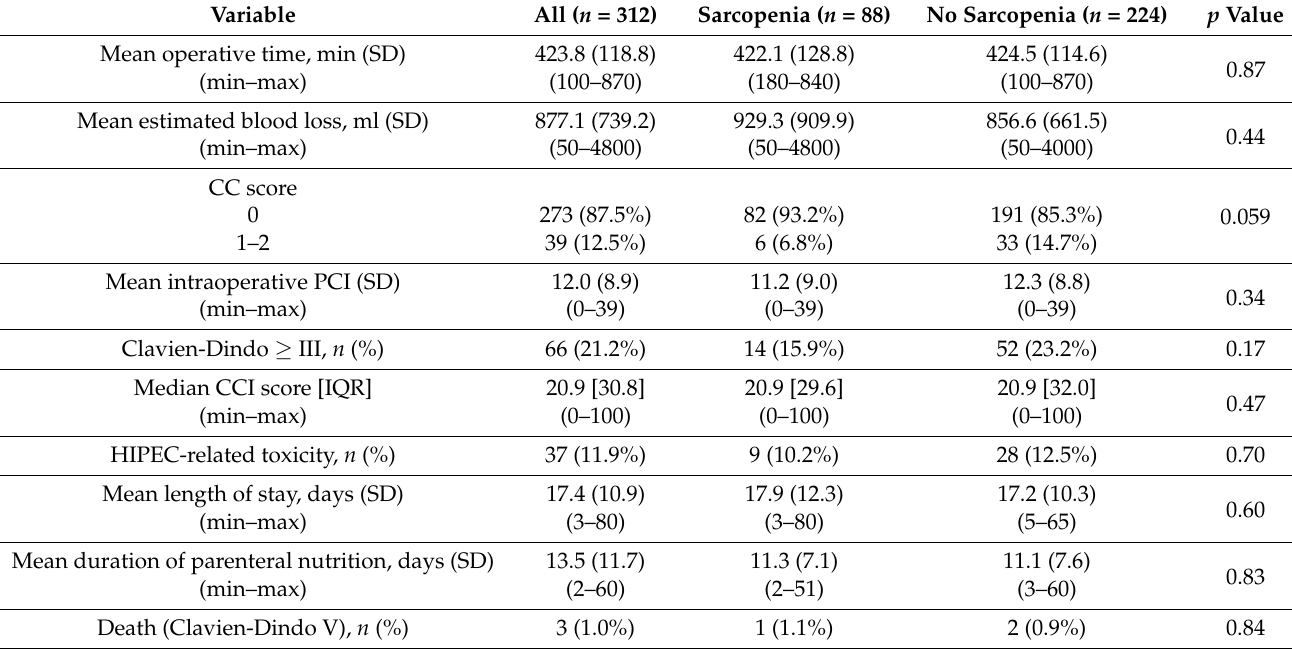
Table 2. Intra- and Postoperative Outcomes.